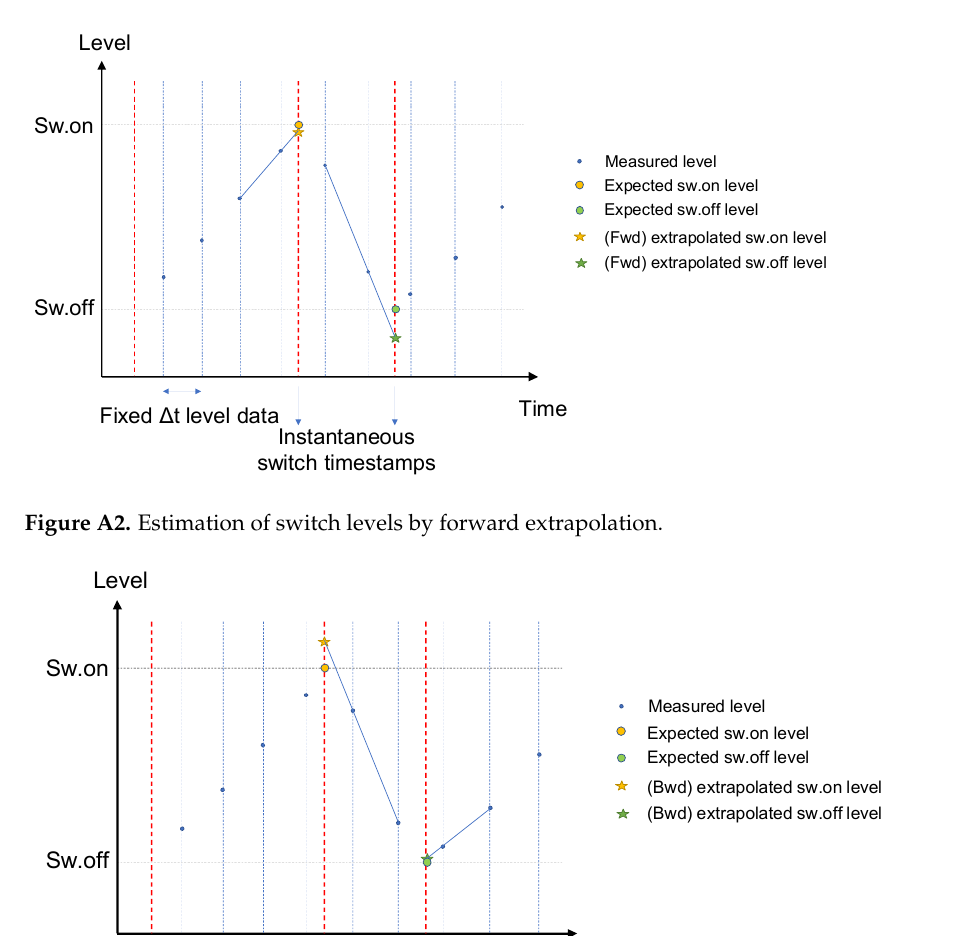
Sw.off Sw.on Fixed Δt level data Instantaneous switch timestamps Time Level